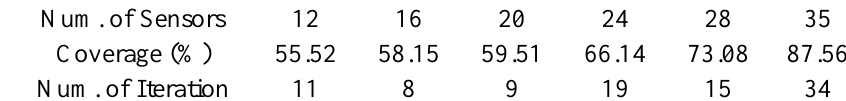
Table 2. Impact of increasing the number of sensors on the coverage using context-aware method in case of considering the restricted area (Zones 1 and 2).